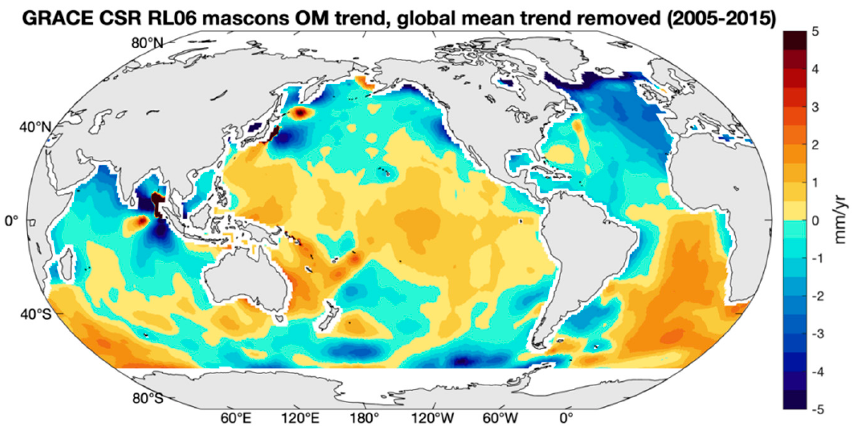
Figure 9. Regional linear trend map of GRACE ocean mass (OM) from the CSR solution for the time interval January 2005–December 2015. The global mean linear trend has been removed. A 200 km buffer zone has been applied along the coasts.